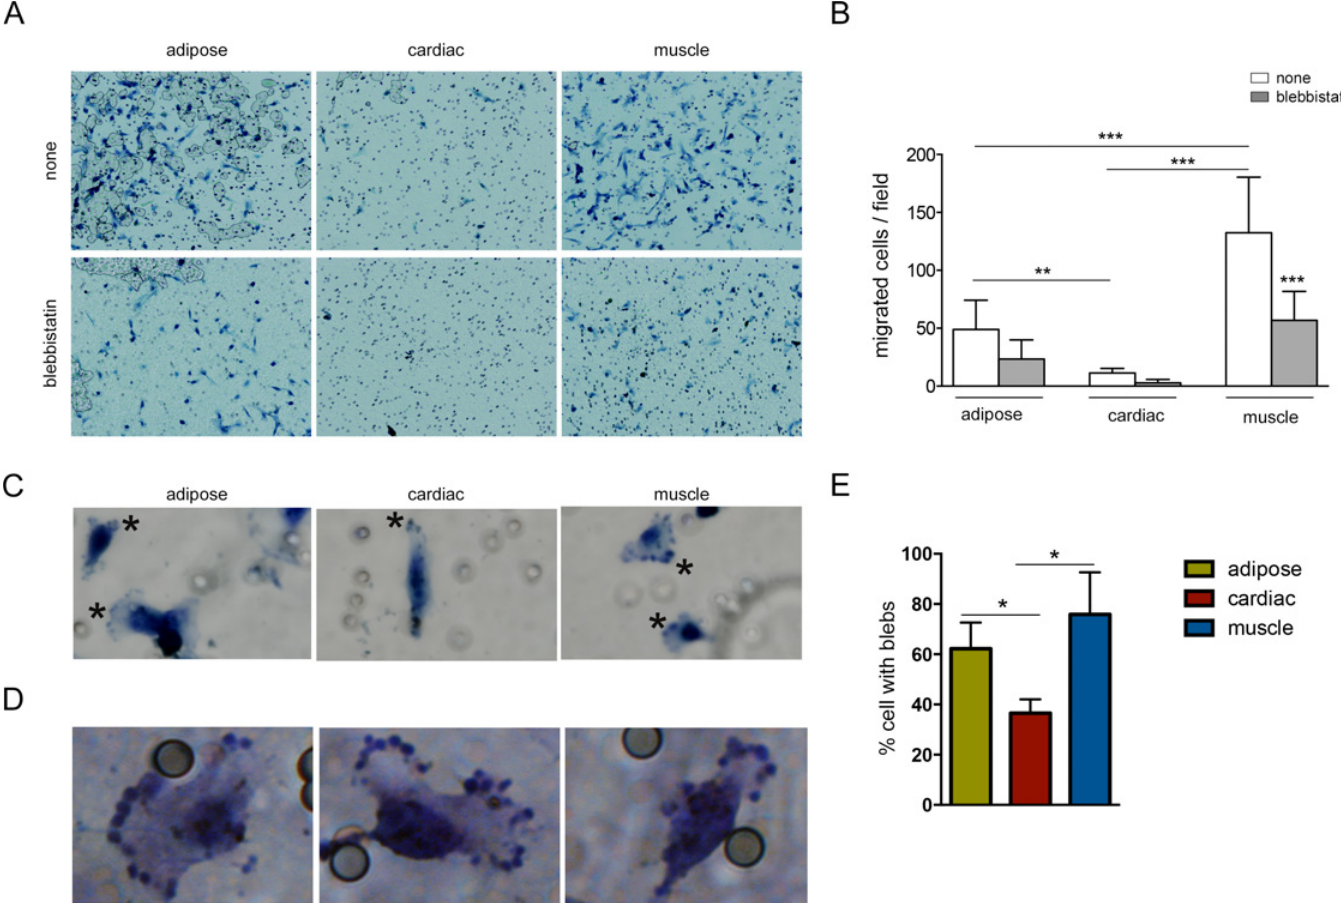
Fig 6. MP Transwell migration assay. (A) Representative images from five randomly selected 10x fields of MPs with/without blebbistatin are shown. (B) Data are from representative experiment out of three performed and denote mean ± SEM of migrated cells/field; Statistical analysis were performed using One-way ANOVA, Bonferroni post-test; ** P < 0.01; *** P < 0.001. (C) Zoom of cells located at the lower surface of the Transwell pore, showing fan-shaped lamellipodia containing blebs (marked with asterisks) at the leading edge. (D) Higher magnifications of muscle precursors are shown. (E) Quantification of the percentage of cells with blebs in migrating cells; Statistical analysis were performed using Mann-Whitney test; * P <